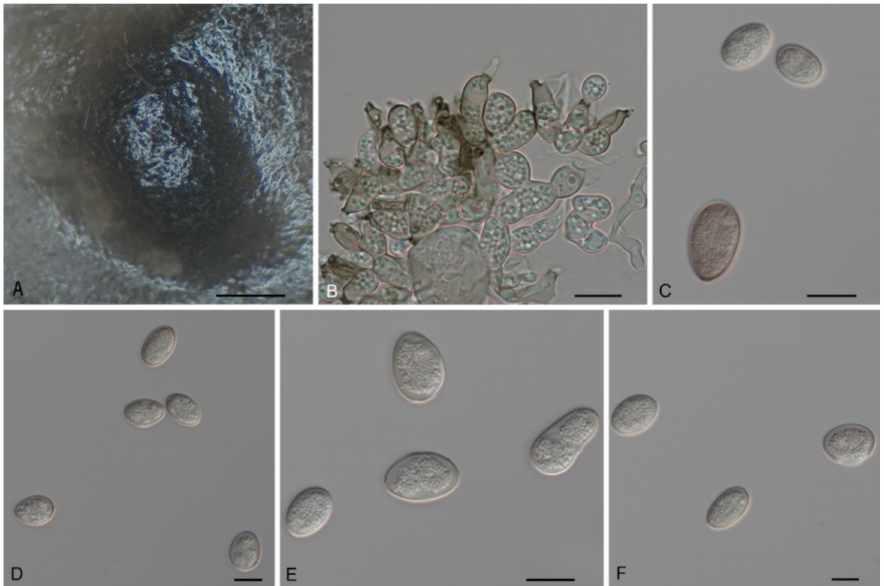
Figure 6. The morphology of Tubakia americana clade I (CFCC 54642). ( A ) Conidioma formed on PDA; ( B ) Conidiogenous cells giving rise to conidia; ( C – F ) Conidia. Scale bars: ( A ) = 100 µ m; ( B – F ) = 10 µ m.